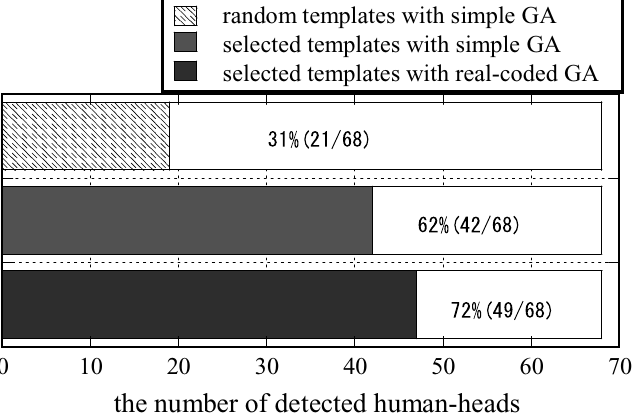
Fig. 5. Success rates of detecting human heads by the template matching methods with random templates & simple GA, the selected templates & simple GA and the selected templates & read-coded GA.